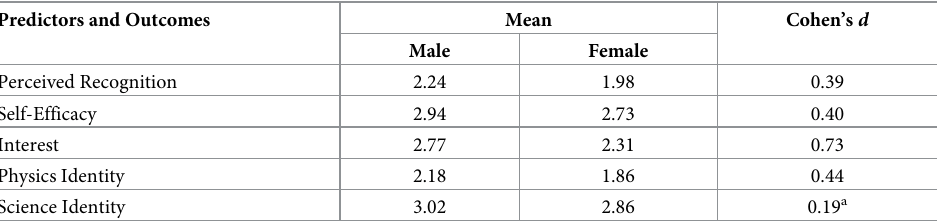
Table 3. Mean construct values by gender as well as statistical significance ( p -values) and effect sizes (Cohen’s d) by gender. No superscript means p -values are < 0.001 and superscript “a” means p -value = 0.006. Predictors and